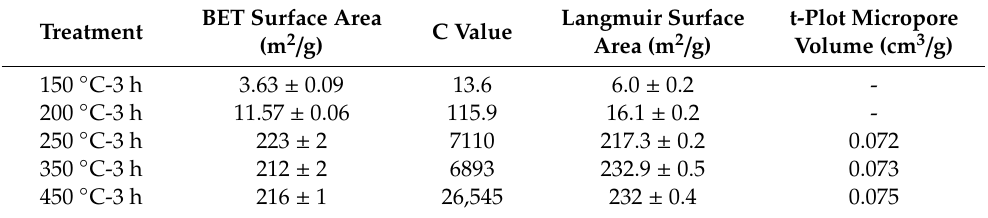
Table 1. BET and Langmuir surface area for Ce 5 (BDC) 7,5 (DMF) 4 different temperature treatments.